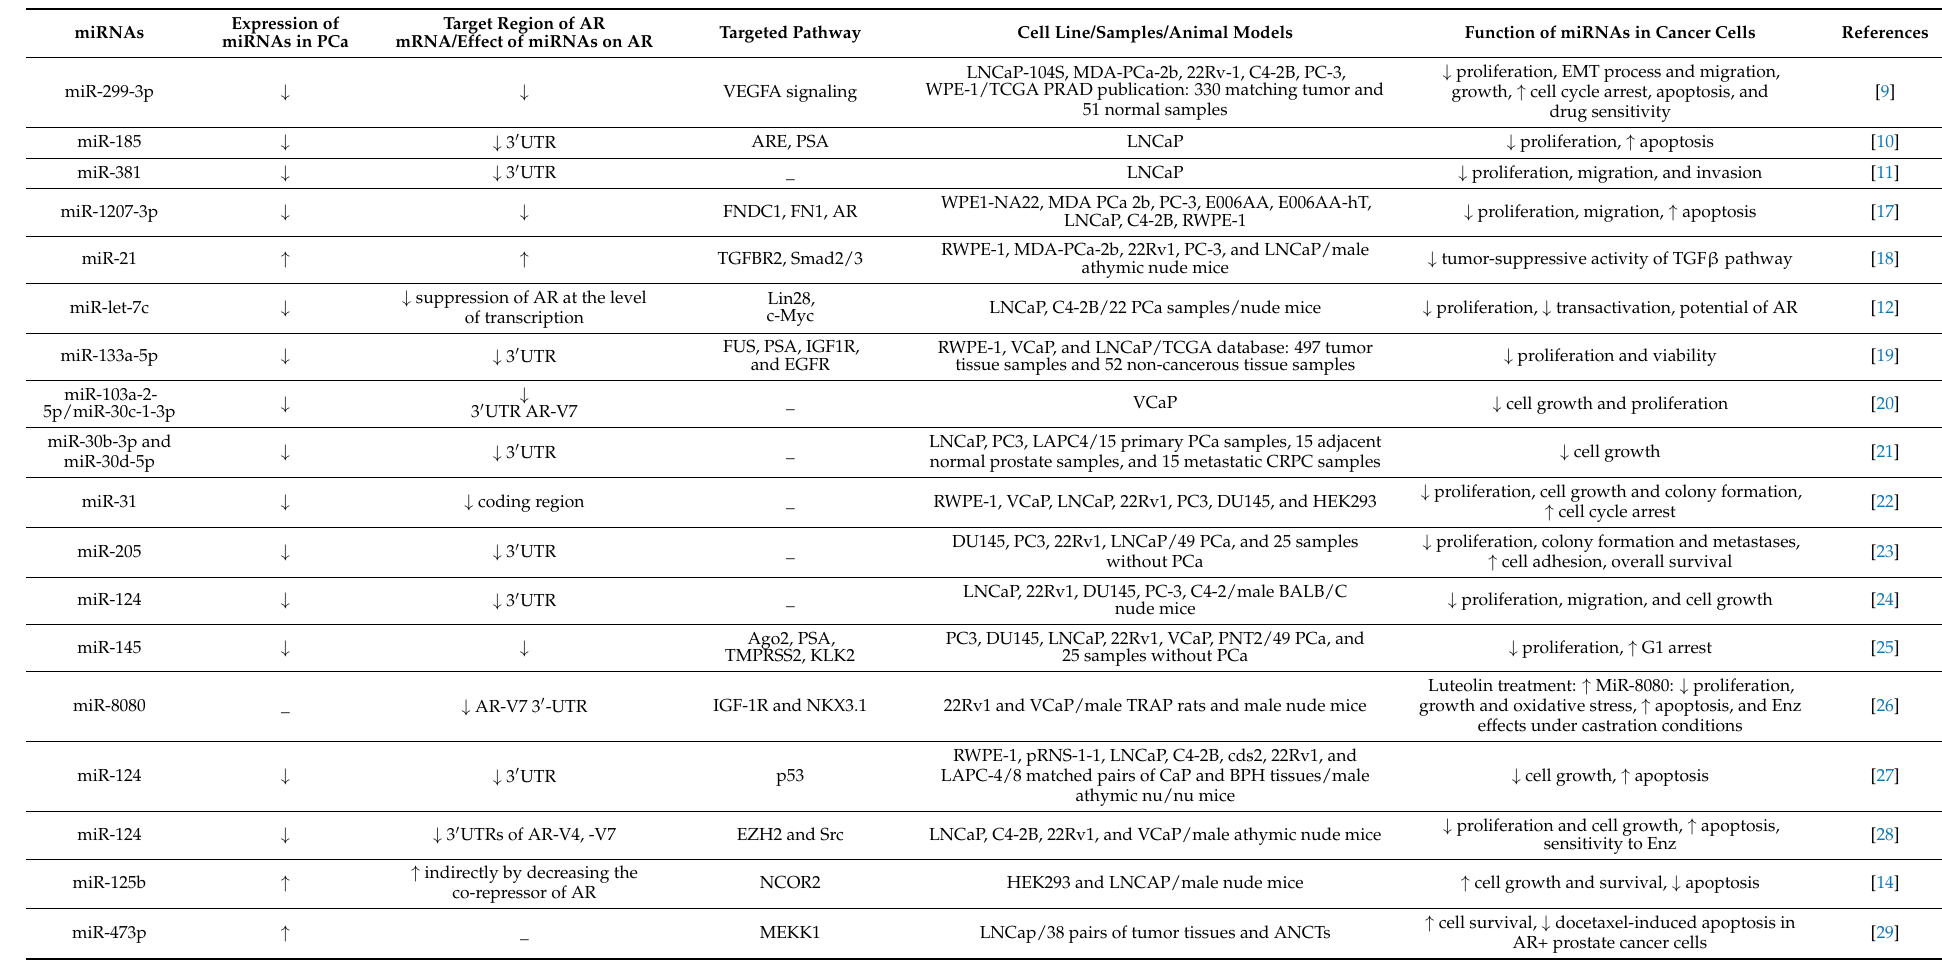
Table 1. The effects of different miRNAs on AR in prostate cancer (prostate cancer (PCa), FUS: fused in sarcoma, AR-V7: androgen receptor variant 7, BCa: breast cancer, BPH: benign prostatic hyperplasia, ANCTs: adjacent non-cancerous tissues, PEITC: phenethyl isothiocyanate, Enz: enzalutamide, CIN: cervical intraepithelial neoplasia, AI: androgen-independent, 5-hmC: 5-Hydroxymethylated cytosine, ↓ : decrease in, ↑ : increase